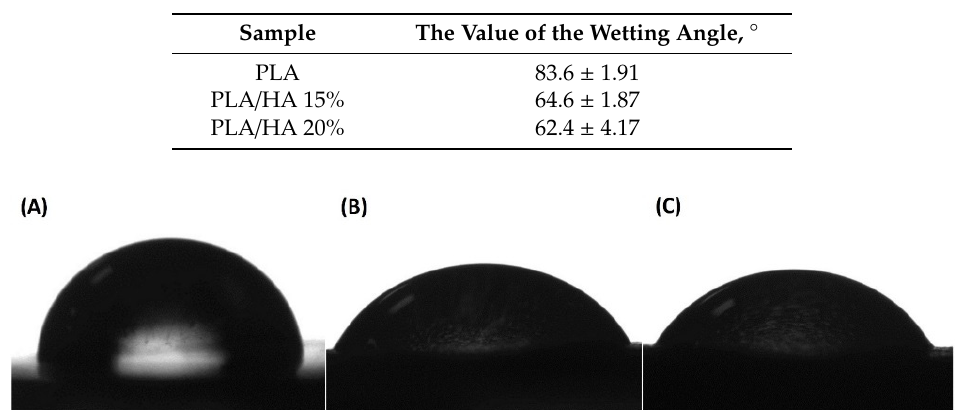
Figure 4. Image of droplets on the surface of samples of PLA ( A ), PLA/HA 15% ( B ), and PLA/HA 20% ( C ).